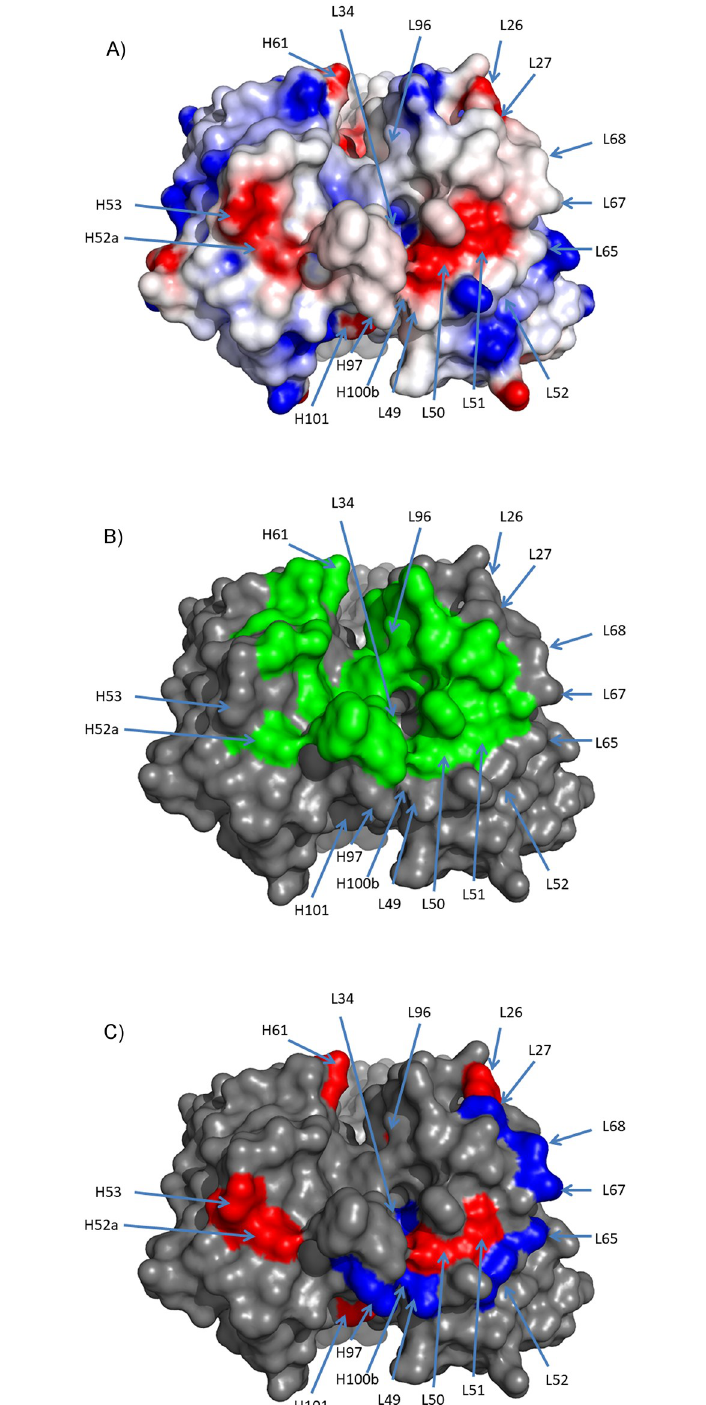
Fig 5. Round 2 design of viscosity reducing mutations. Mutations in round 2 were based off of R2-001 and were designed to be similar to the L53 mutation, introducing net-positive charge changes adjacent to the proximal negative charge patch. These mutations were designed to not interfere with binding. Additionally, negatively charged residues in negative charge patches were also designed to be removed. Here the mutations were selected to minimize the effect on binding. The charge patches were identified by generating an electrostatic potential energy surface using Delphi [30–32]seen in (A). Here red is negative charge potential and blue is positive charge potential. The interface residues